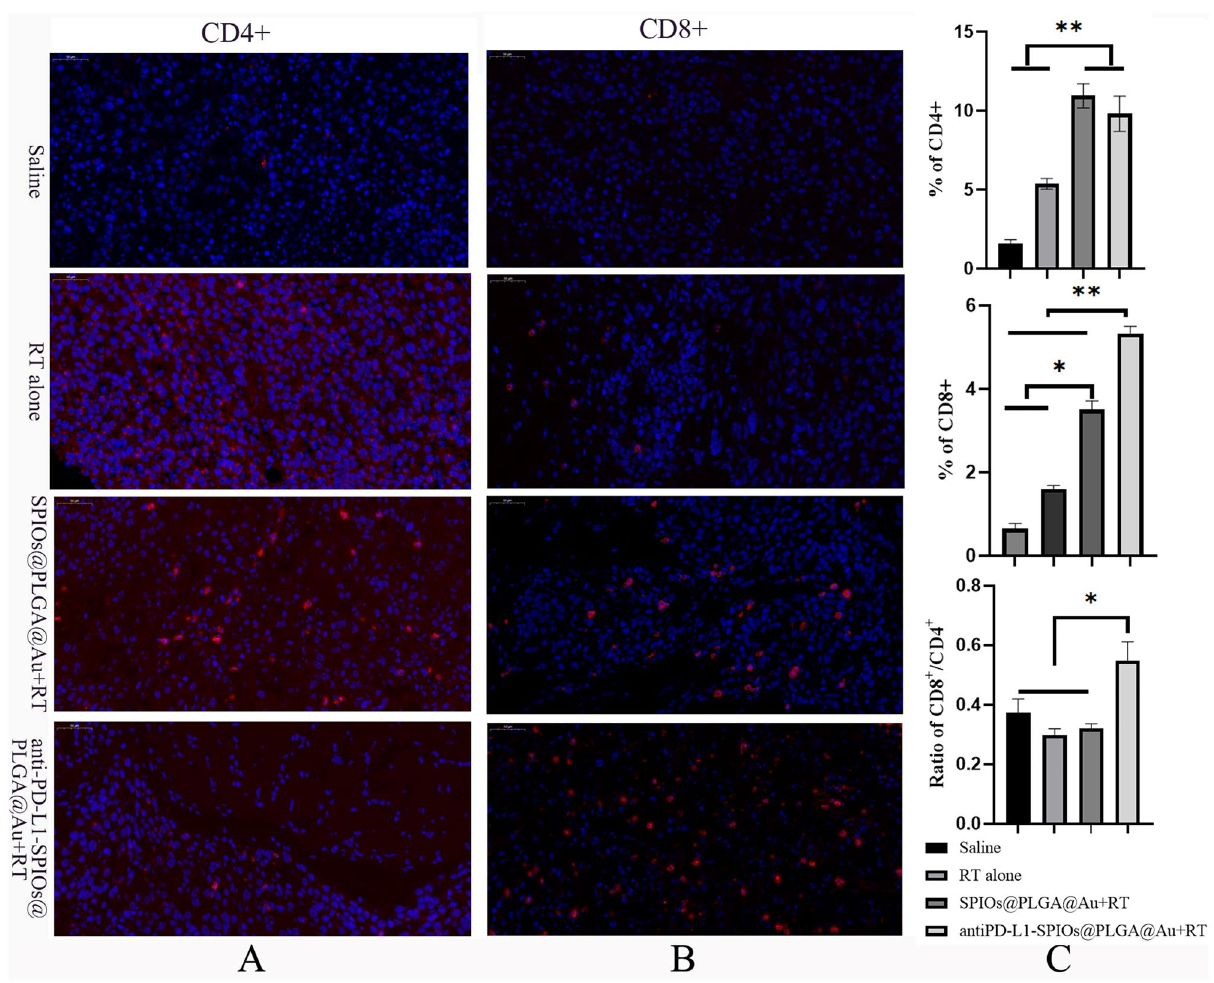
Figure 6. ( A ) Representative immunofluorescence images of tumor slices stained by anti-CD4 antibody (red). ( B ) Representative immunofluorescence images of tumor slices stained by anti-CD8 antibody (red). ( C ) Proportions of tumor-infiltrating CD8 + T cells and CD4 + T cells, and the ratio of CD8 + /CD4 + T cells in the